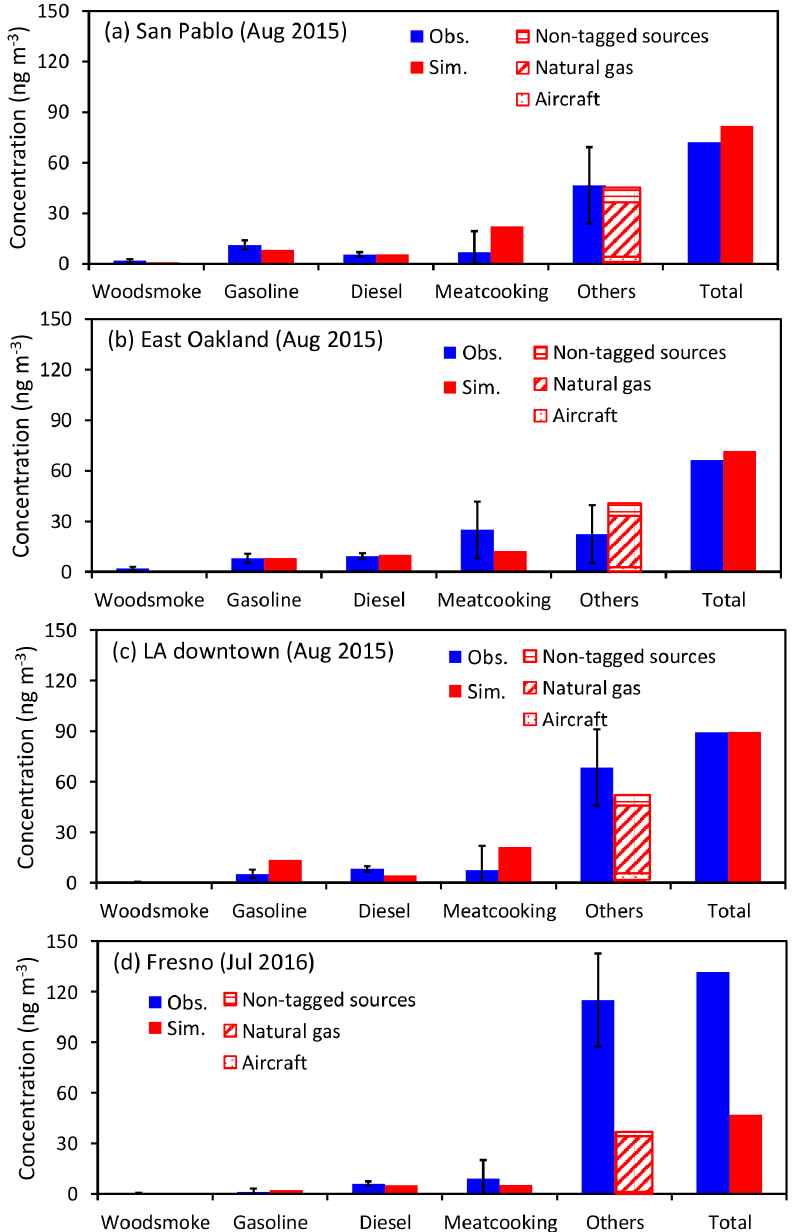
Figure 5. Source contribution to PM 0 . 1 predicted by the chemical mass balance (CMB) receptor model and the UCD/CIT model at four sites in California in August 2015. CMB results are calculated using 3d average measurements composited for a full